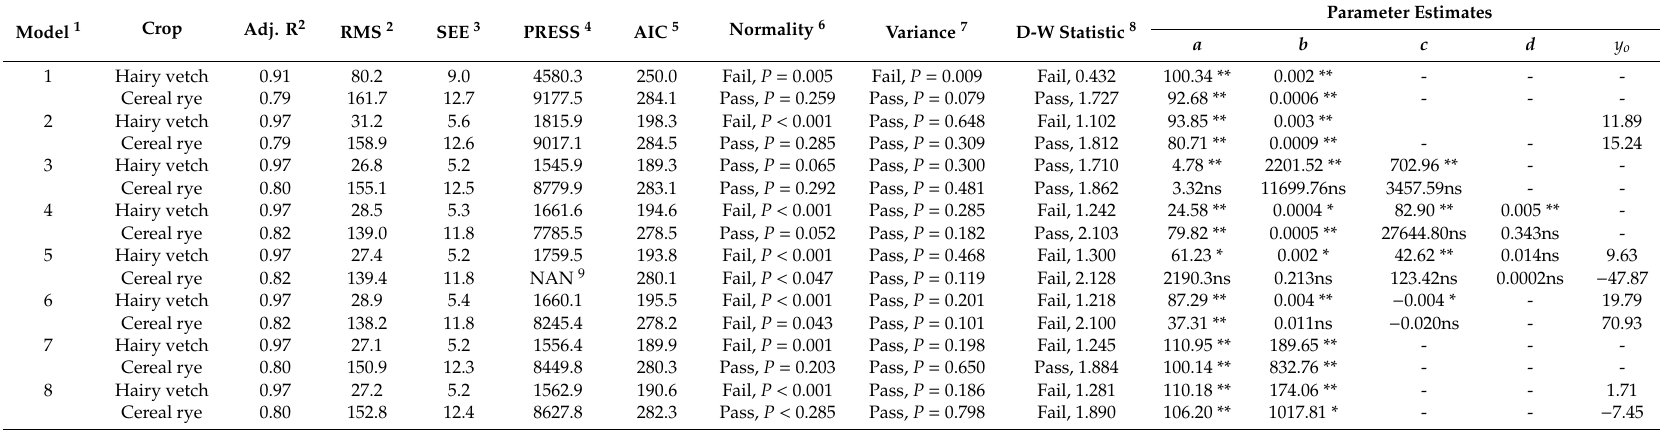
Table 1. Evaluation of models used to describe percent mass remaining of aboveground biomass of hairy vetch and cereal rye cover crops at Exp. 1 in 2015. Data were from no-till plots at Carbondale,